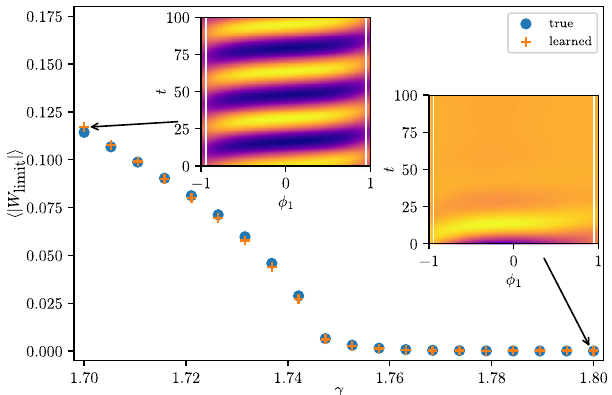
Fig. 4 Computational bifurcation diagram by plotting the mean amplitude 〈 ∣ W ∣ 〉 averaged over the ensemble at the limit set. In particular, we limit integrate from random initial conditions close to the limit set for T = 10000 dimensionless time units for the Stuart-Landau ensemble (blue circles) and the learned PDE (orange crosses). A mean amplitude near zero indicates convergence to the fi xed-point W = 0 ∀ ω , whereas a non-zero 〈 ∣ W limit ∣ 〉 indicates oscillations with fi nite amplitude. The color codings of the insets show the real part of the complex variable W obtained from integrating an initial condition close to the fi xed point W k = 0 with γ = 1.8 (right inset) and close to the limit cycle with γ = 1.7 (left inset) using the learned model and employing explicit forward Euler for γ = 1.8 > γ H